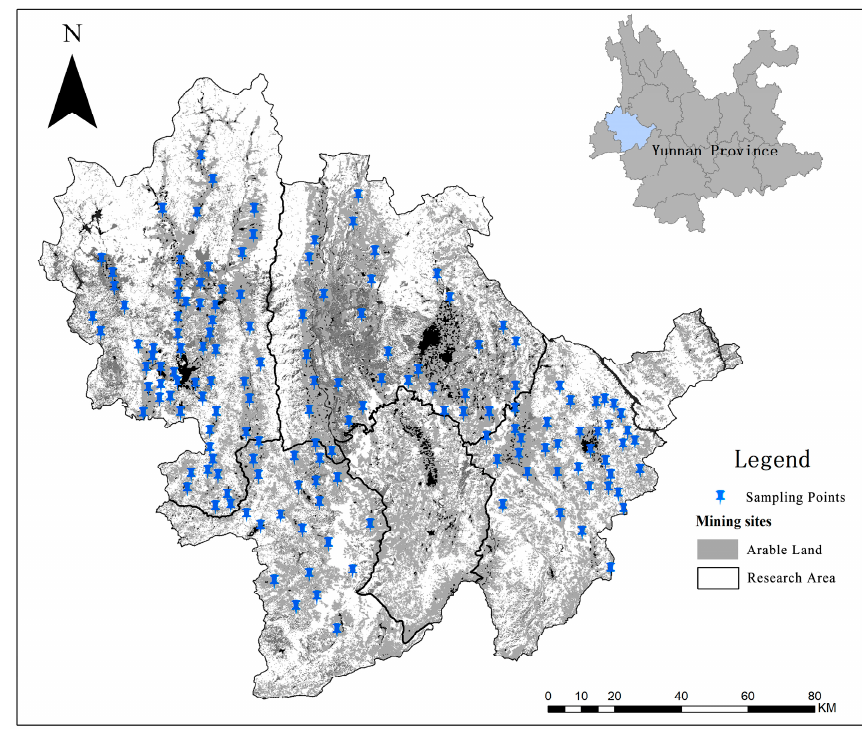
Figure 1. Sampling locations of the study area.